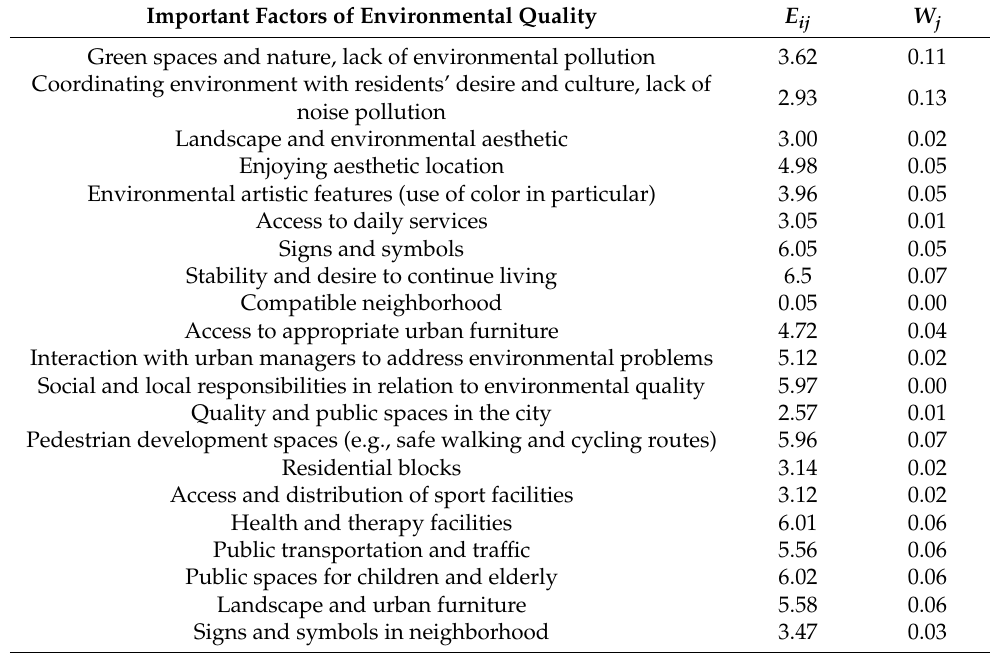
Table 6. Comparison of E ij and W ij for important factors of environmental